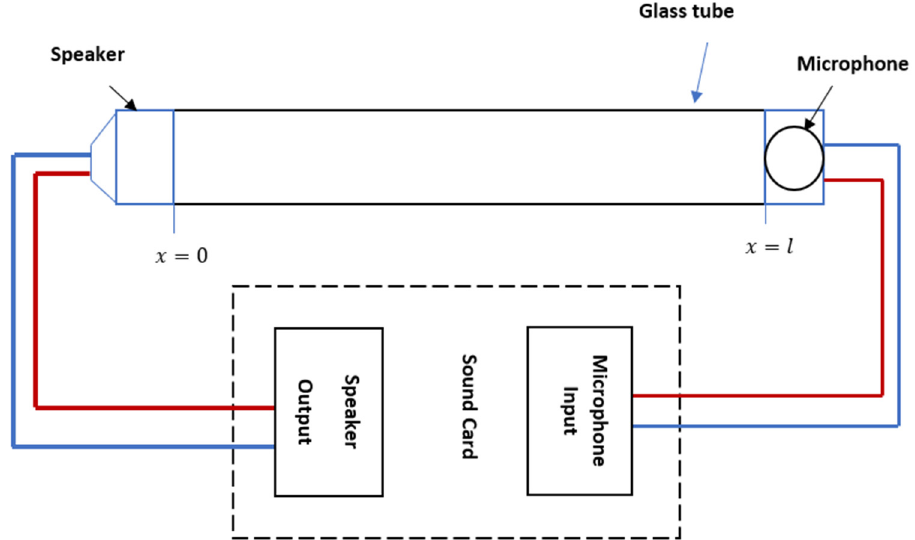
Figure 1. The shape of a resonance tube in which a standing wave is created.